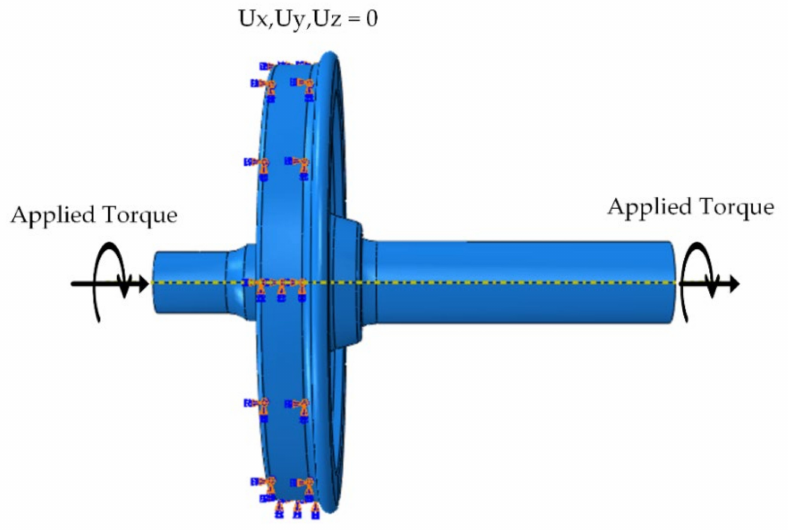
Figure 18. Loading and boundary conditions for the torque